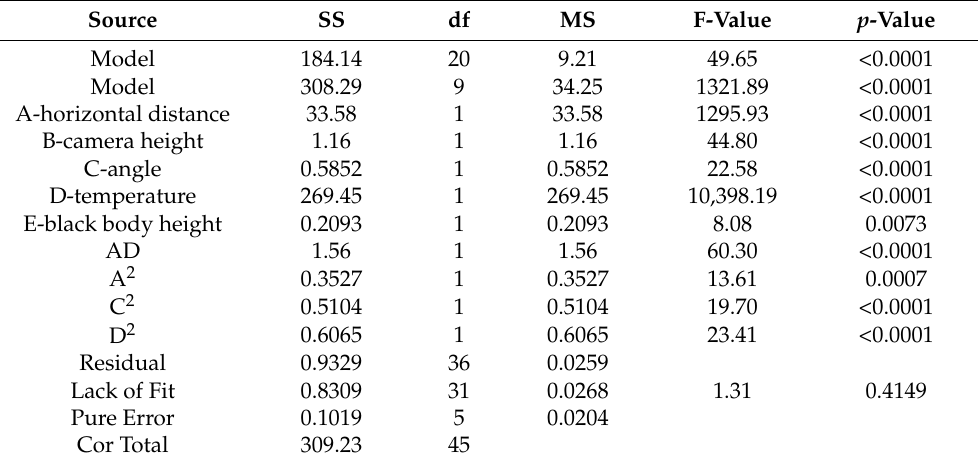
Table 4. MANOVA for RSM